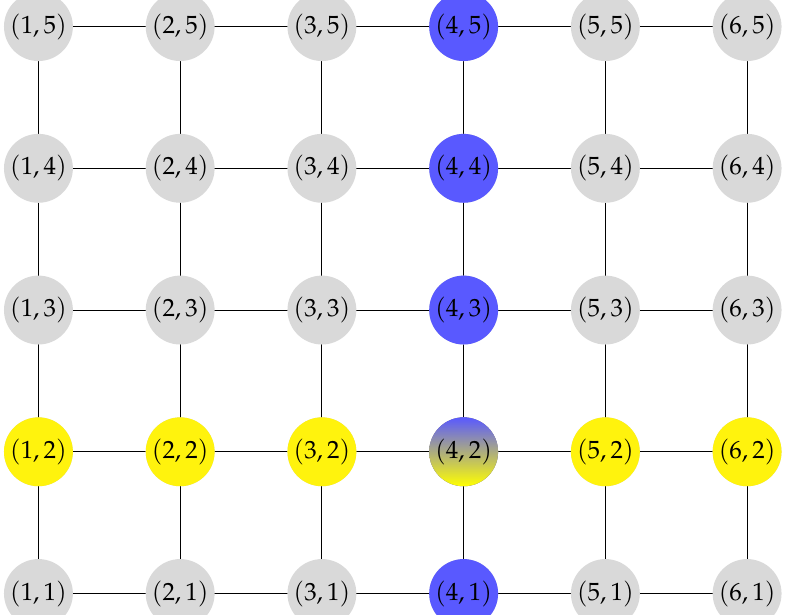
Figure 1. A grid graph G [ 6,5 ] . Column C 4 is denoted by blue, row R 2 is denoted by yellow.